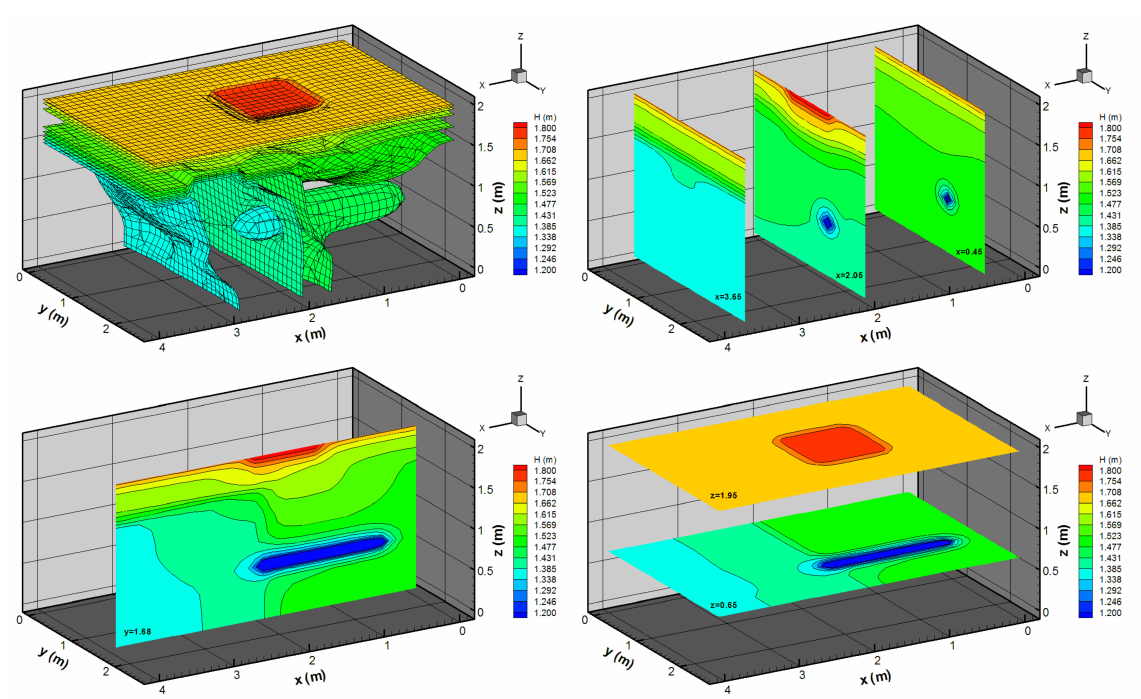
Figure 18. Contours of the matrix hydraulic head H (m) at t = 75.0